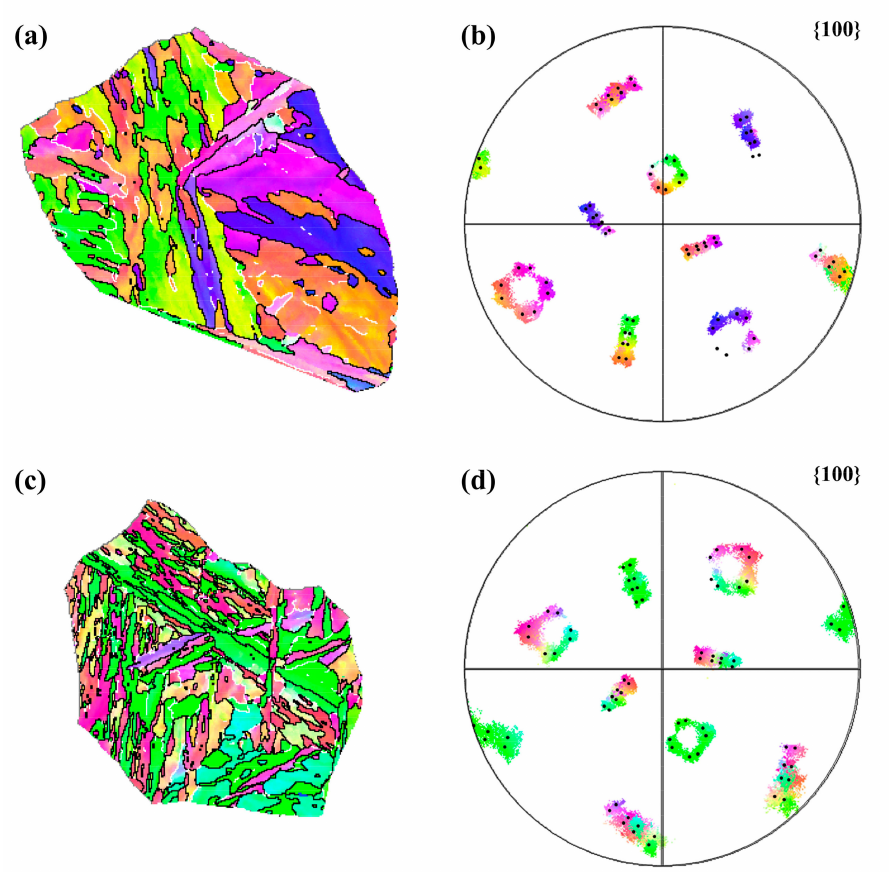
Figure 4. Inverse pole figure (IPF) and pole figure (PF) of representative grains of two steels cooled at 0.5 ◦ C/s: ( a , b ) G1 of 0.16C-0.92Ni steel and ( c , d ) G2 of 0.12C-1.86Ni steel. (Black dotted graphs: theoretical polar plot based on K–S relationship; colored graphs: experimental pole